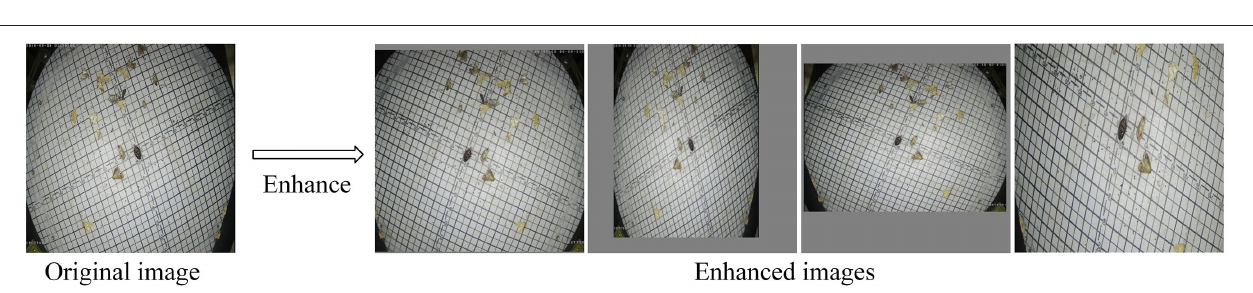
instances of specific pests by cropping and pasting and generating new images and xml files as shown in Figure 3